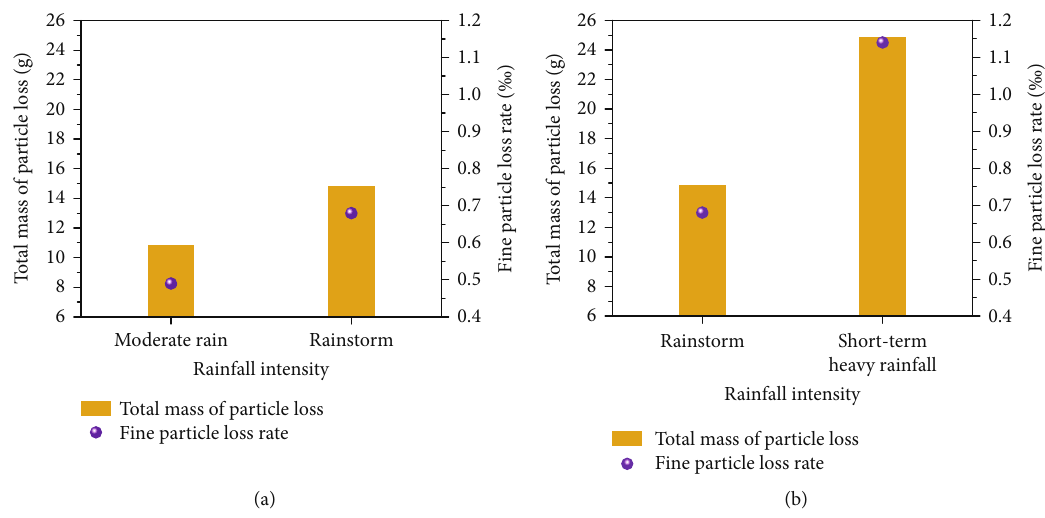
Figure 8: Variation of fi ne particle loss mass in fi ller under di ff erent rainfall conditions: (a) fi ne particle loss mass under di ff erent rainfall intensities with the same rainfall duration; (b) fi ne particle loss mass under di ff erent rainfall intensities with the same rainfall